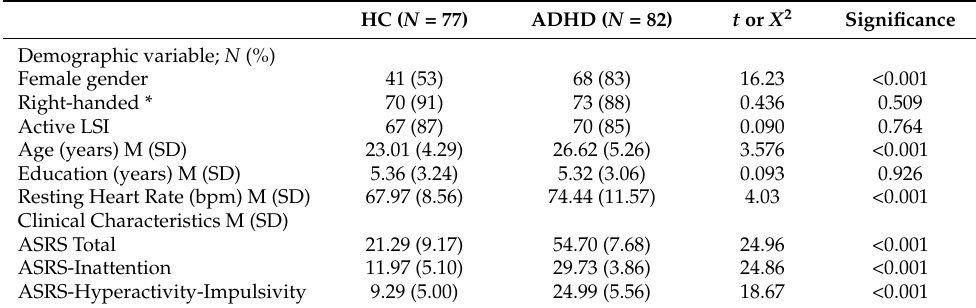
Table 1. Baseline demographic and clinical characteristics of the two